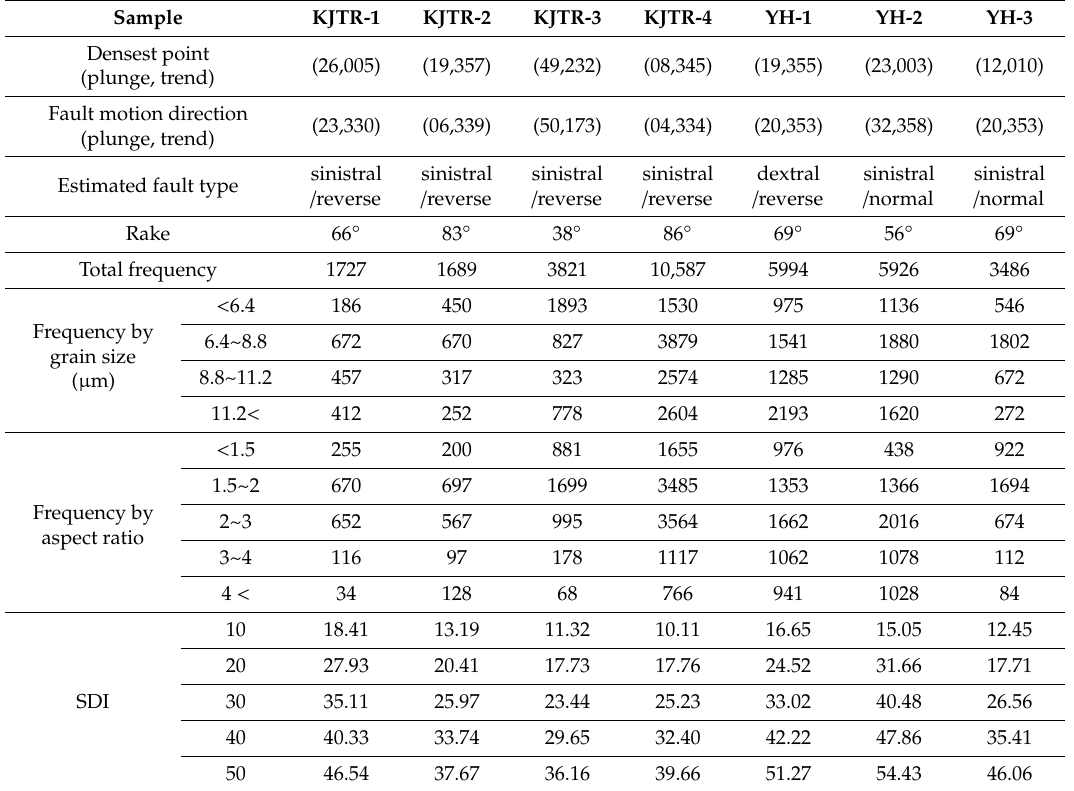
Table 2. Densest point and fault motion direction, which is expressed by plunge and trend form, estimated fault type, and rake value. Frequency of a given grain size and aspect ratio for all target grains examined for SPO and SDI values for each sample are also provided. SDI examples with γ -values ranging from 10 to 50 for the 3D-SPO results of the fault gouge are presented for the KJTR-1, -2, -3, and -4 and YH-1, -2, and -3